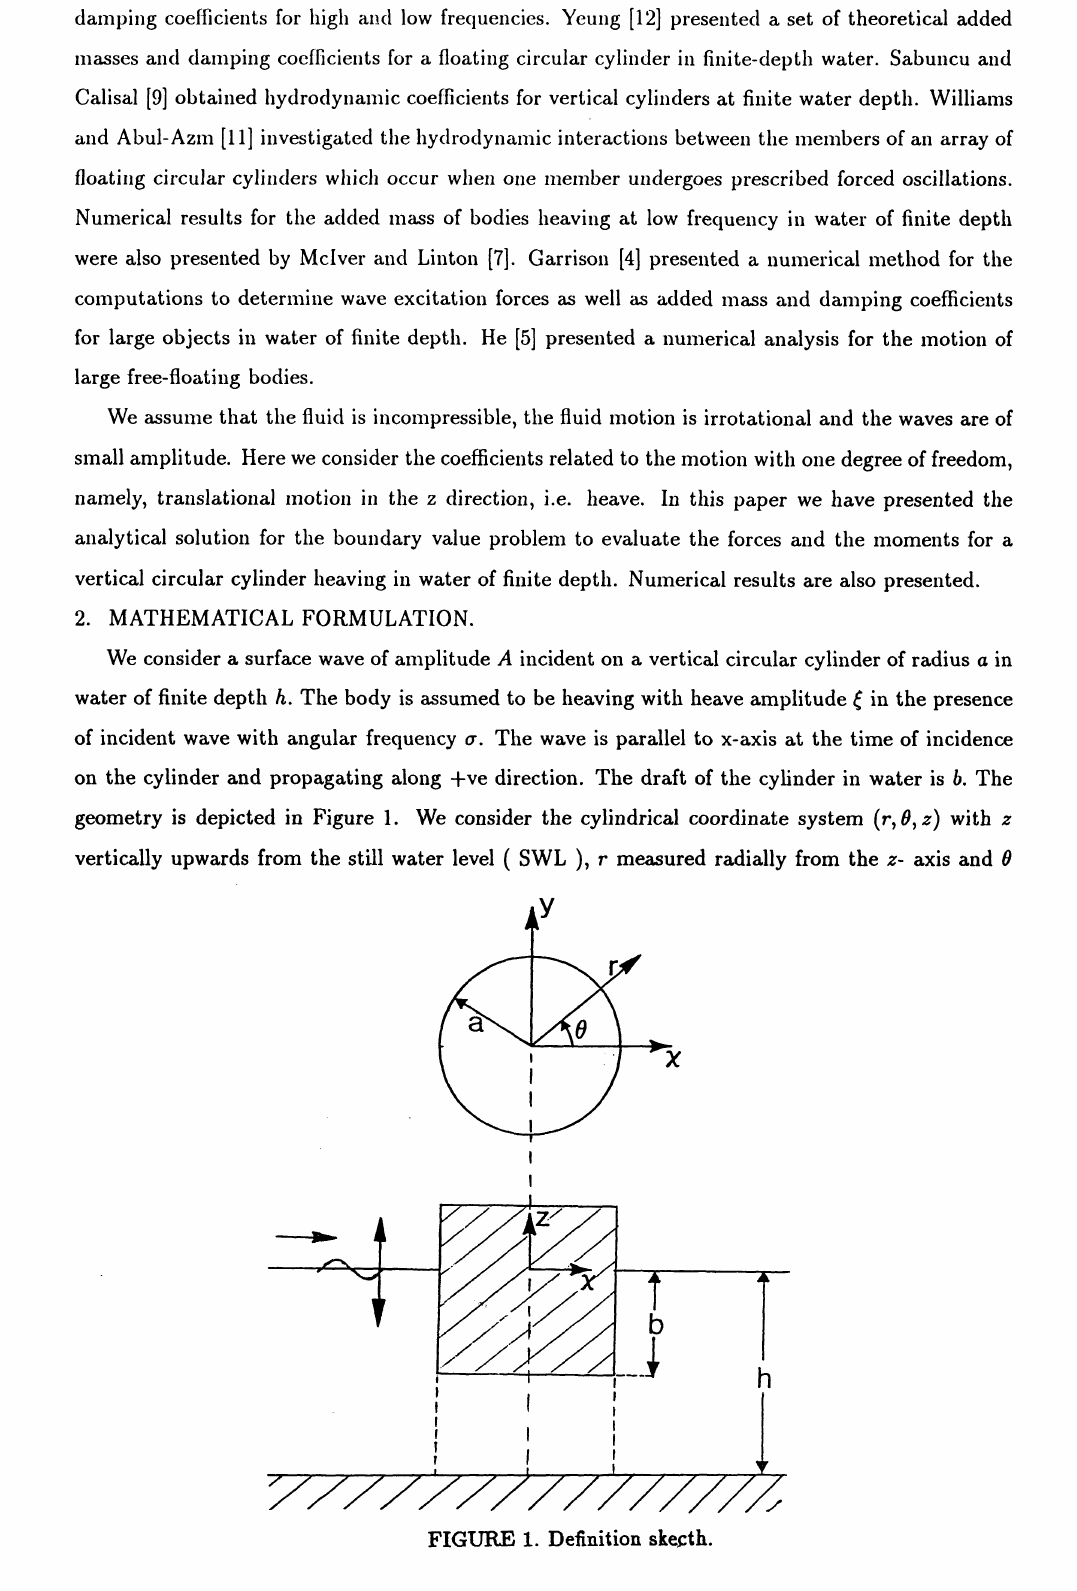
FIGUBJB 1. Deqnition